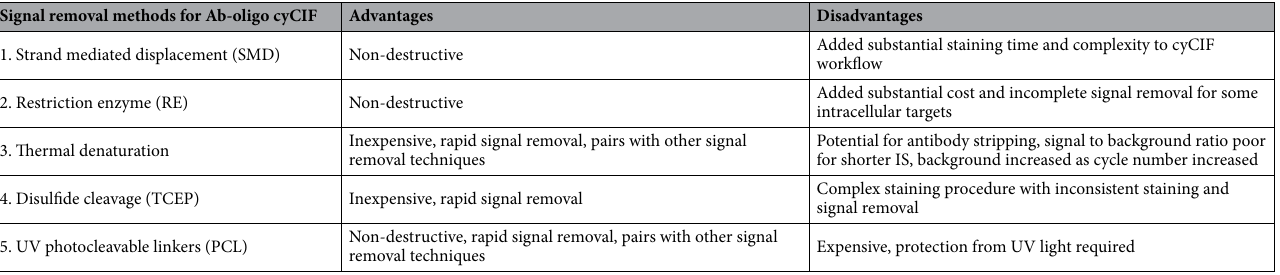
Table 1. Comparison of Ab-oligo cyCIF signal removal